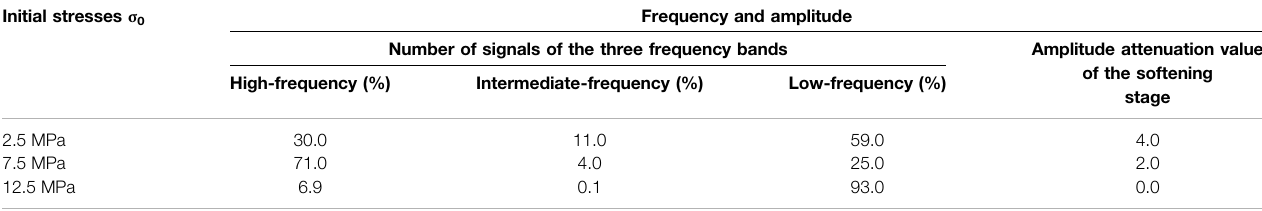
TABLE 6 | Number of signals of the three frequency bands and amplitude attenuation value of the softening stage under different initial stresses. Initial stresses σ